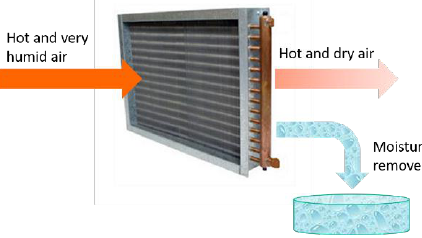
Figure A2. Schematic of MRD functionality.